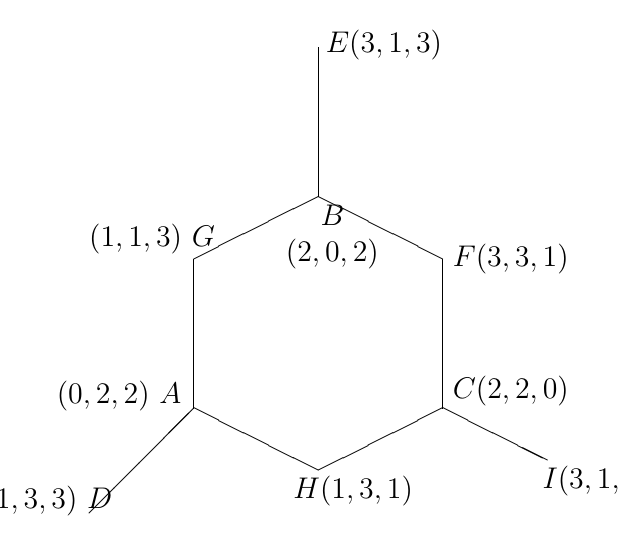
Figure 1: An Initial